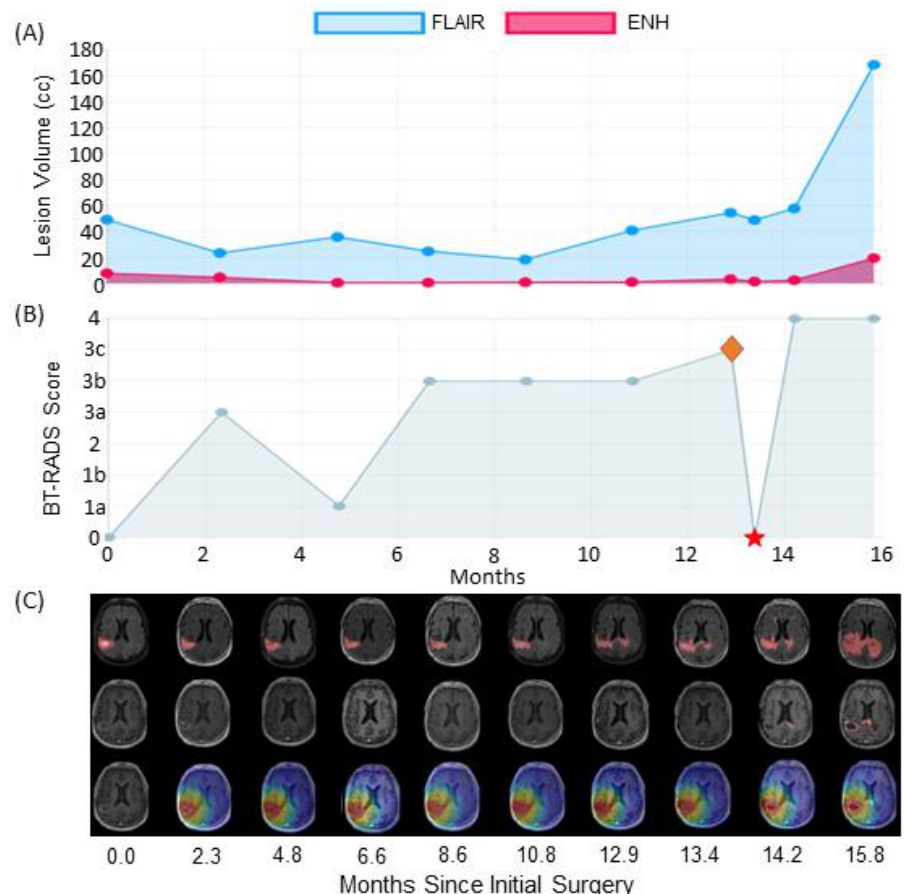
Figure 5. ( A ) A graph of changing lesion volumes from FLAIR and T1w-CE (labeled ENH) imaging can help assess suspicious trends, especially after re-resection in this case. ( B ) A graph of BT-RADS scores during a patient’s follow-up. The red star indicates re-resection of suspected lesions. This patient had one follow-up surgery that found 30% tumor in samples biopsied (13.4 months). There- fore, their recurrence date (orange diamond) was set before their follow-up surgery. ( C ) For each follow-up visit in the above graph, the FLAIR MRIs (top row), T1w-CE MRIs (middle row), and radiation dose map overlaid on T1w-CE MRIs (bottom row) are displayed. From the 14th month onwards, a second lesion is apparent on the contralateral side of the brain outside of the radiation treatment zone. 4. Discussion In this study we describe the use of novel imaging visualization tools and structured reporting to analyze the results to date of our 30-patient clinical trial utilizing dose-esca- lated radiation guided by Cho/NAA sMRI maps. With standard-of-care therapy including standard RT with concurrent and adjuvant TMZ, GBM prognosis remains poor with a median OS that is consistently limited to about 16 months and an incidence of recurrence at one year from start of treatment of 60 – 70% [2]. Our results from our single arm study show a substantial improvement with a one-year incidence of recurrence of 30% and me- dian PFS of 16.6 months. For the sake of comparison, Avastin, an anti-angiogenic therapy commonly used for newly-diagnosed GBM patients, minimally improved OS to a timepoint lower than the median PFS calculated in our pilot study (16.1 months) [15]. While these results are promising, we must caution that our pilot study had a much smaller sample size compared to historical controls and the Avastin trial and at the very least, justifies a larger consortium-level trial to determine a true effect size. We have pre- viously reported a median OS for this cohort of 23.0 months [7,32]. In another trial (NRG Oncology BN001 NCT02179086) that escalated radiation dose guided only by standard